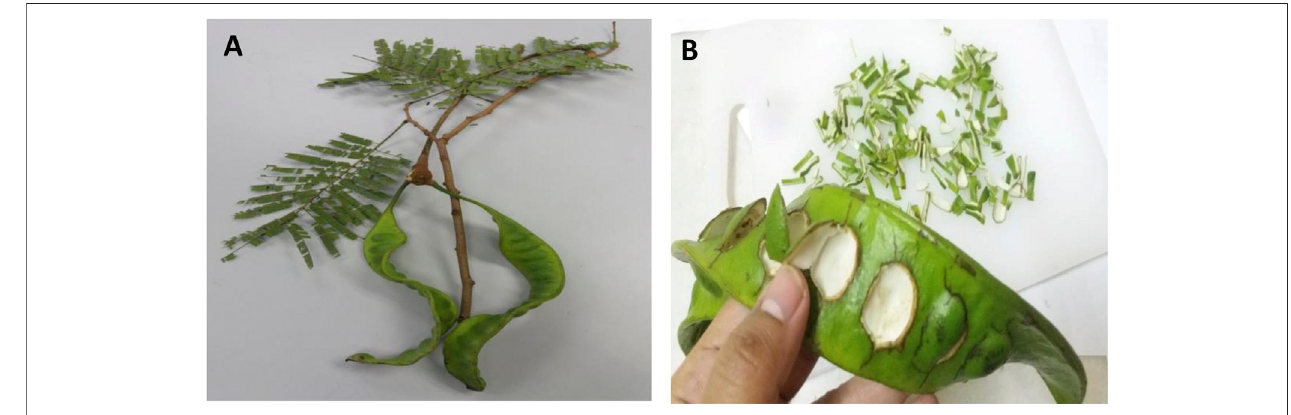
FIGURE 1 | (A) Parkia speciosa pods and (B) its slived deseeded pod.